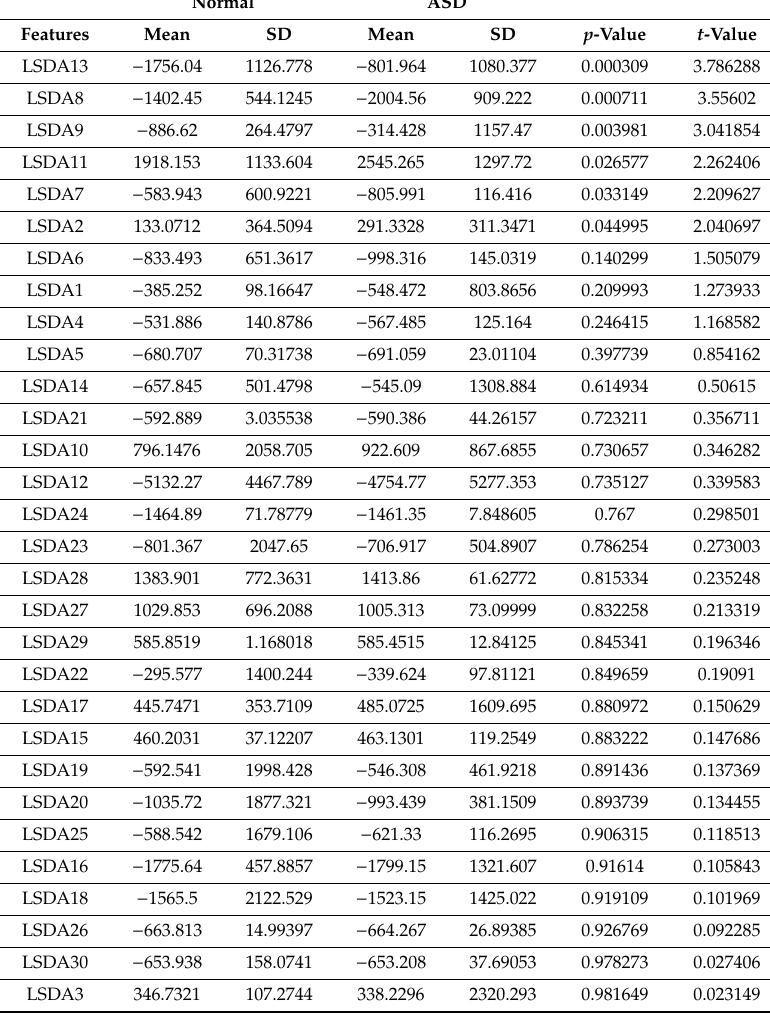
Table 2. Range (mean ± standard deviation) of features selected using t -test after linear discriminant analysis (LDA) feature